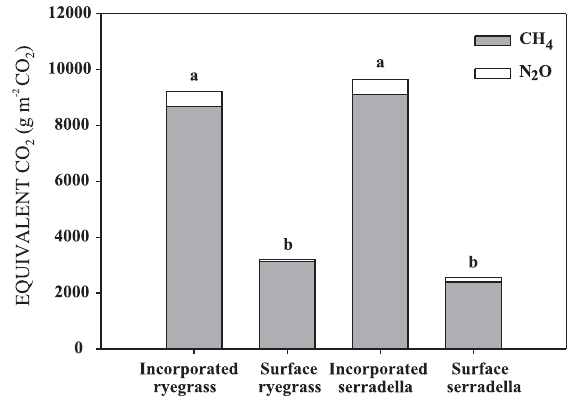
Figure 8. Accumulated CH expressed in equivalent CO Albaqualf with rice under residue managements (incorporated or left on the soil surface) of ryegrass and serradella. Different letters on bars indicate statistical difference by Tukey’s test at 5